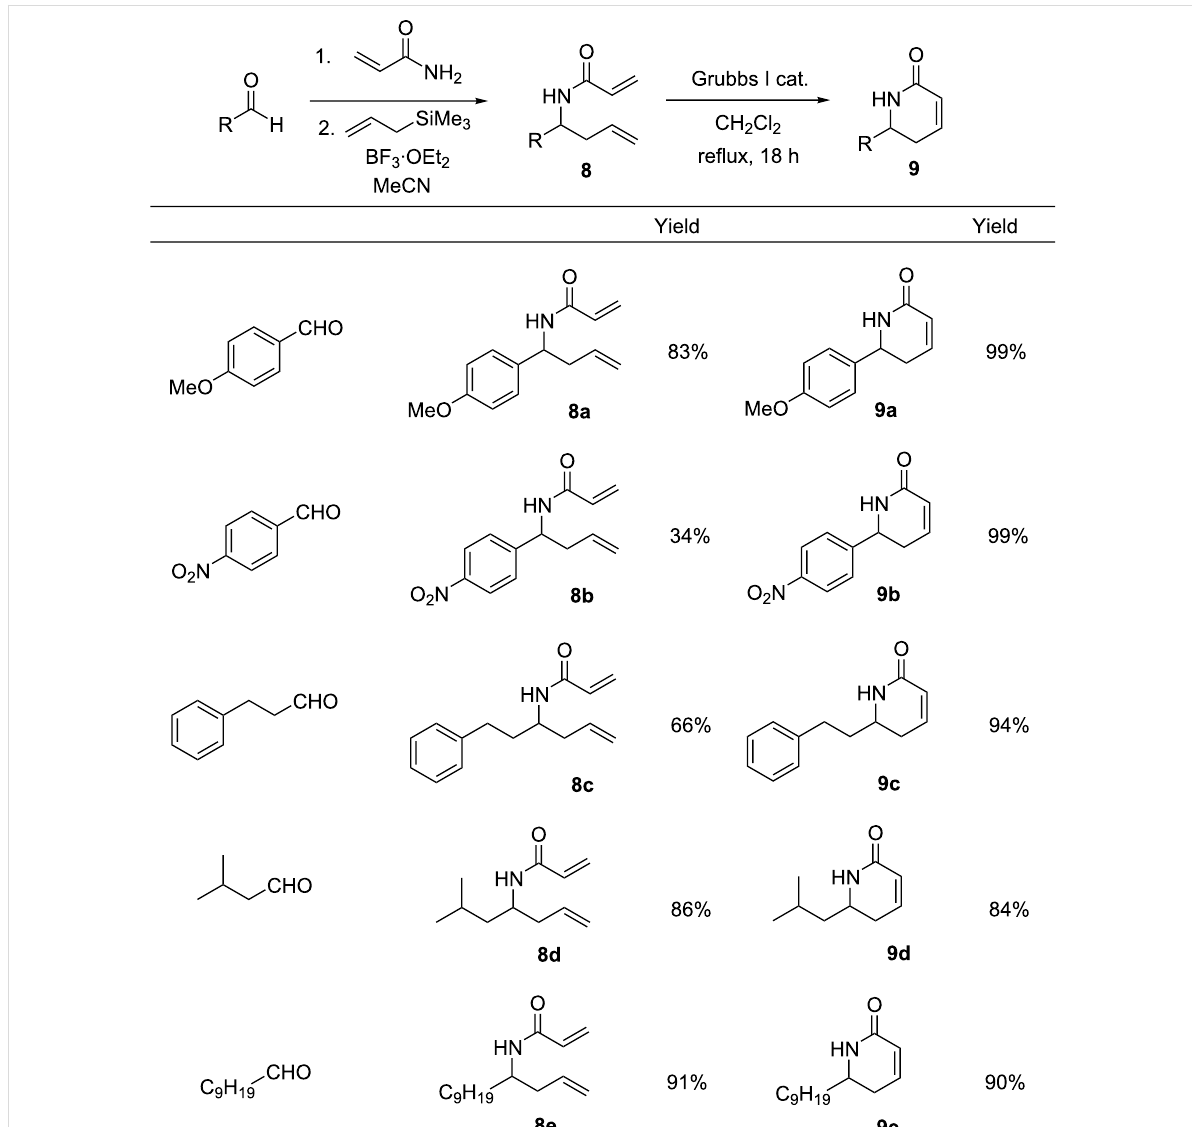
process, producing dihydropyridinones 9a and 9c – e in high yields. The electron-withdrawing substituted aromatic